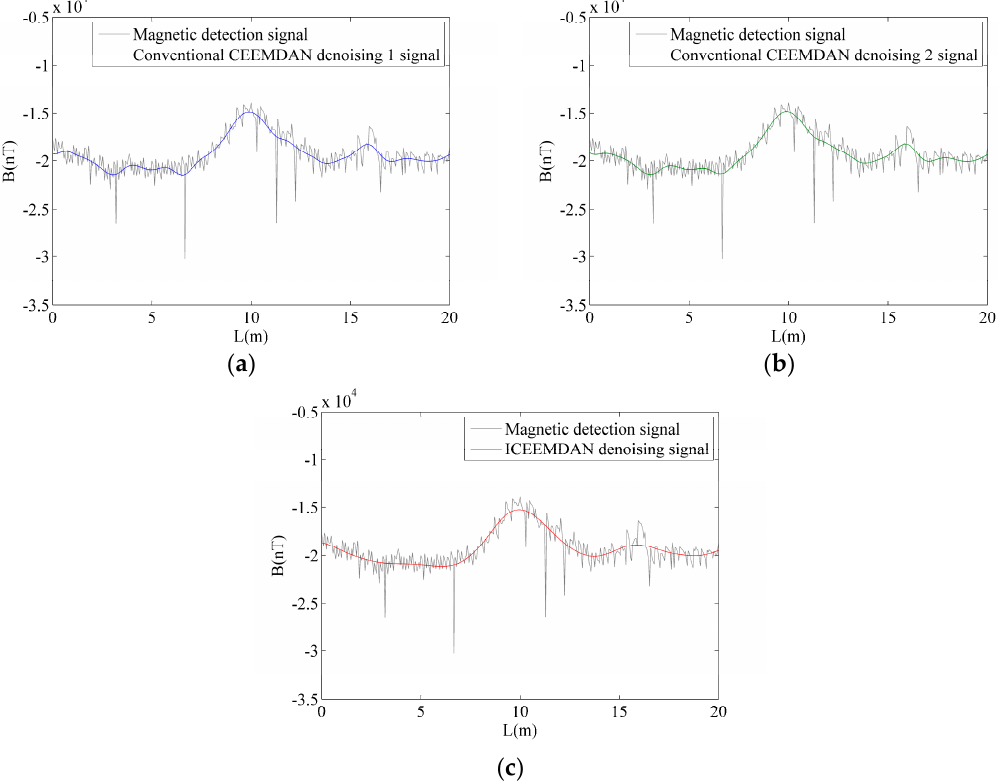
Figure 10. Figure 10. The filtering results of three denoising methods. ( a ) Conventional CEEMDAN denoising 1. ( b ) Conventional CEEMDAN denoising 2. ( c ) ICEEMDAN